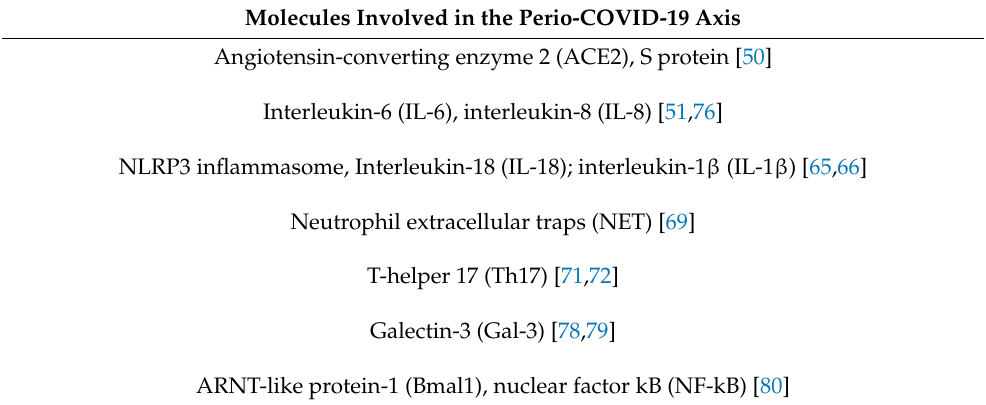
Table 1. Summary of some of the several molecules that are involved in the mechanisms behind the COVID-19 and the periodontitis